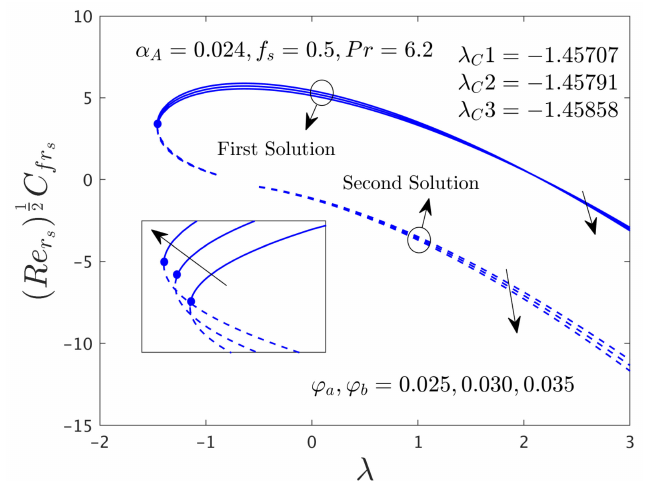
C fr against λ for several values of the hybrid s s